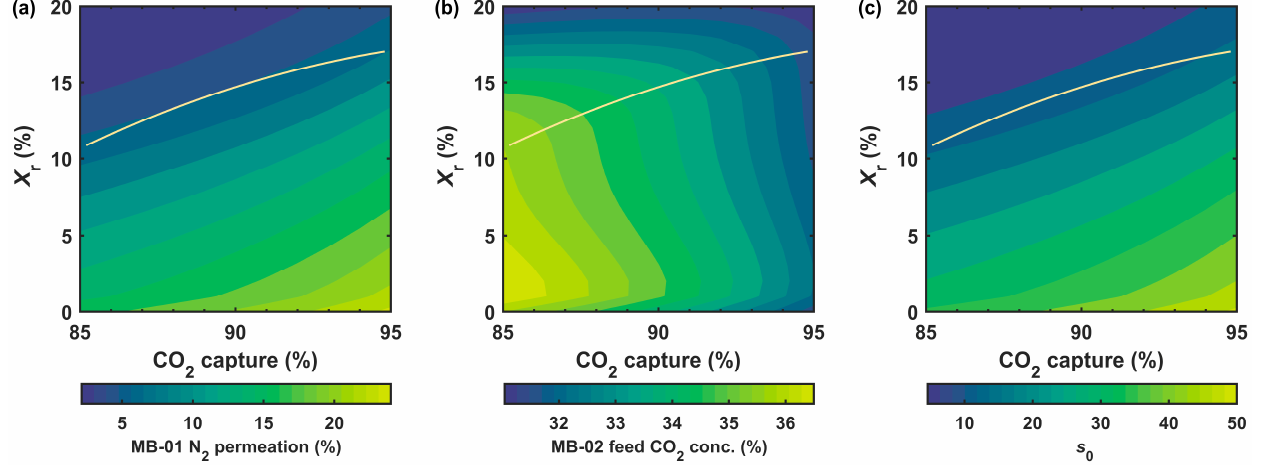
Figure 4. Effect of CO 2 capture degree and retentate recycle ( X r ) on ( a ) MB-01 N 2 permeation, ( b ) feed CO 2 concentration of MB-02, and ( c ) MB-01 dimensionless area ( s 0 ) for the primary capture system. The solid lines are the optimal X r values for different capture